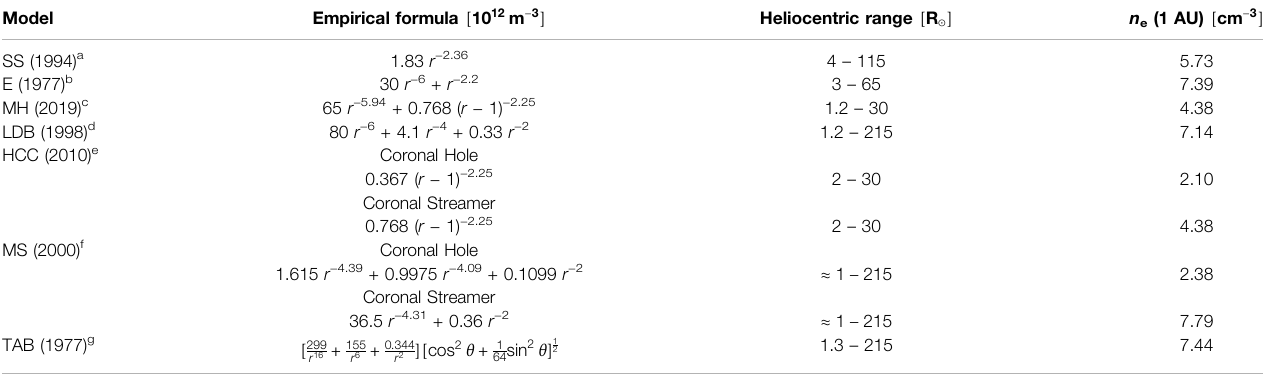
TABLE1| Empirically-determinedcoronalplasmadensitymodelsusedinFRstudies,theirapplicablerange,andvalueat1AU.Heliocentricdistance, r ,isgiveninunitsofR ⊙ . Model